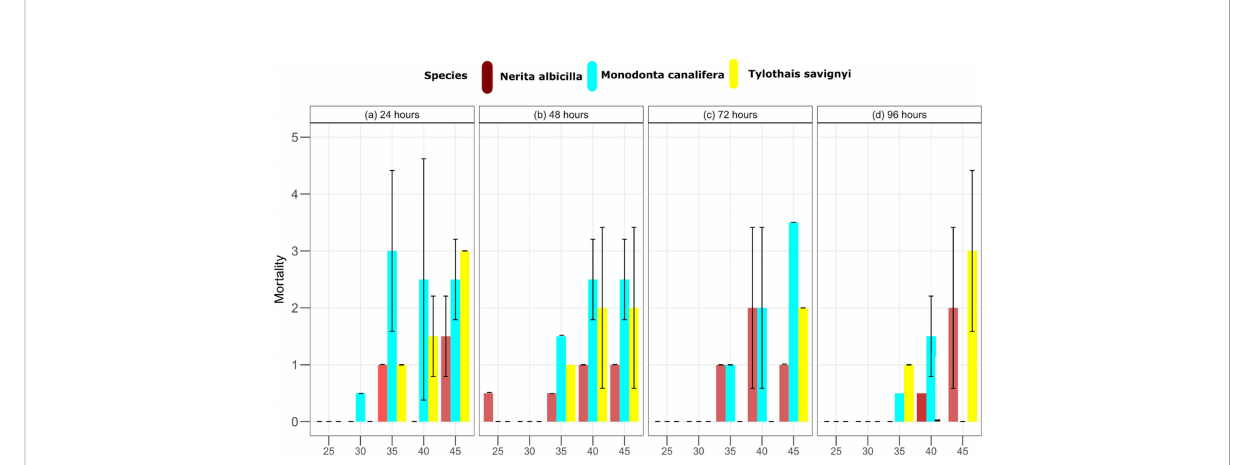
FIGURE 2 LT 50 at constant temperatures of 25, 30, 35, 40, and 45°C at 24-, 48-, 72-, and 96-h duration.